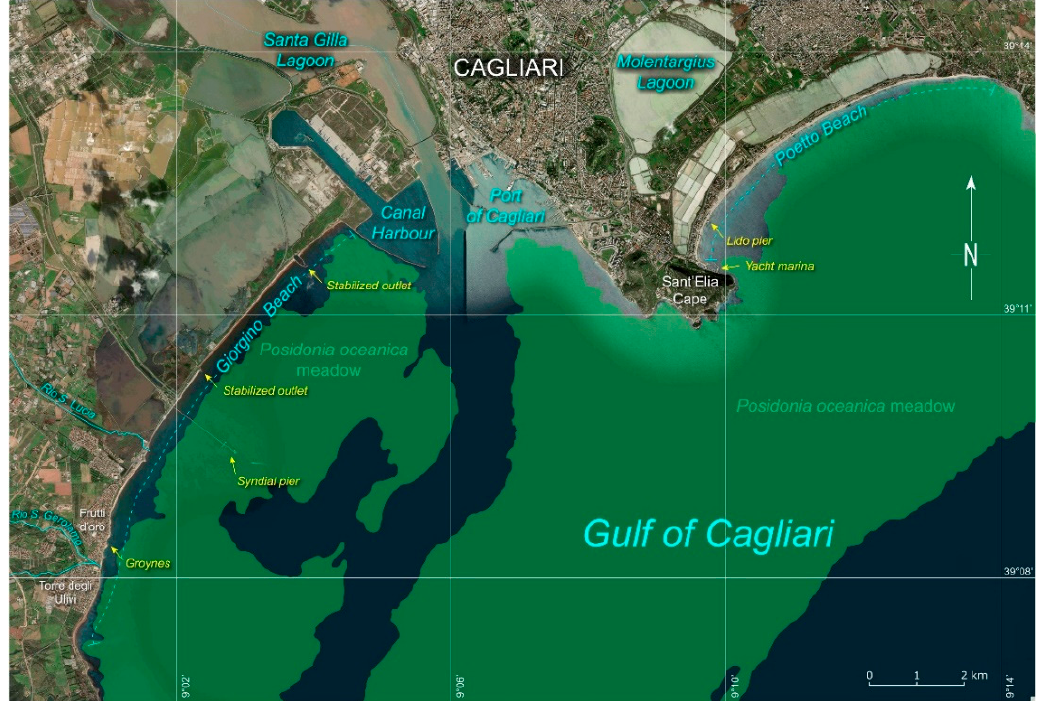
Figure 3. Satellite aerial image acquired over the Gulf of Cagliari showing the main transitional/fresh water bodies, the main coastal developments along the coastlines of Giorgino and Poetto and the distribution of the P . oceanica meadows obtained from [3,9] (Google Earth V 7.3.3.7786; data acquired on the 10/08/2019; data: System Integration Office (SIO), National Oceanic and Atmospheric Administration (NOAA), United States Navy, National Geospatial-Intelligence Agency (NGA), General Bathymetric Chart of the Oceans (GEBCO)).